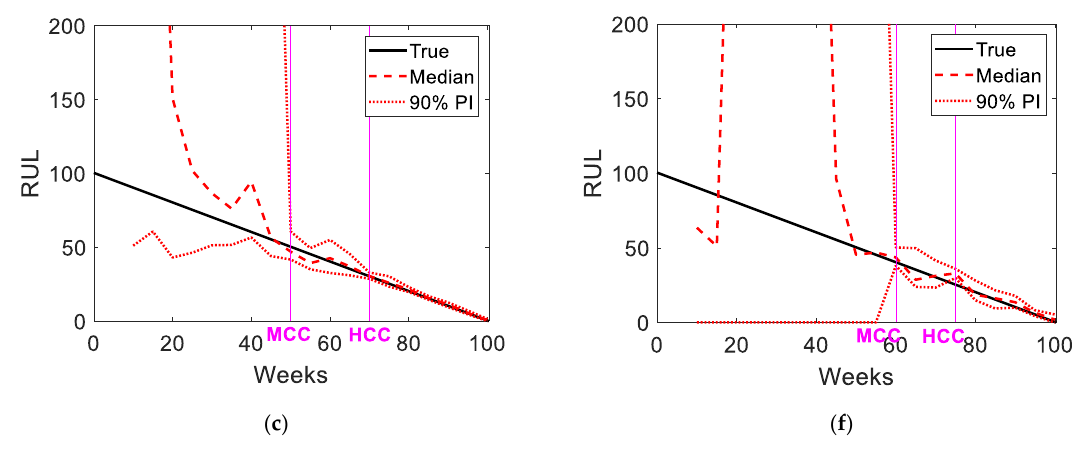
Figure 10. Validation: battery degradation problem. ( a ) Small level of noise: Zone 2, ( b ) small level of noise: Zone 3, ( c ) small level of noise: RUL, ( d ) medium level of noise: Zone 2, ( e ) medium level of noise: Zone 3, ( f ) medium level of noise: RUL.